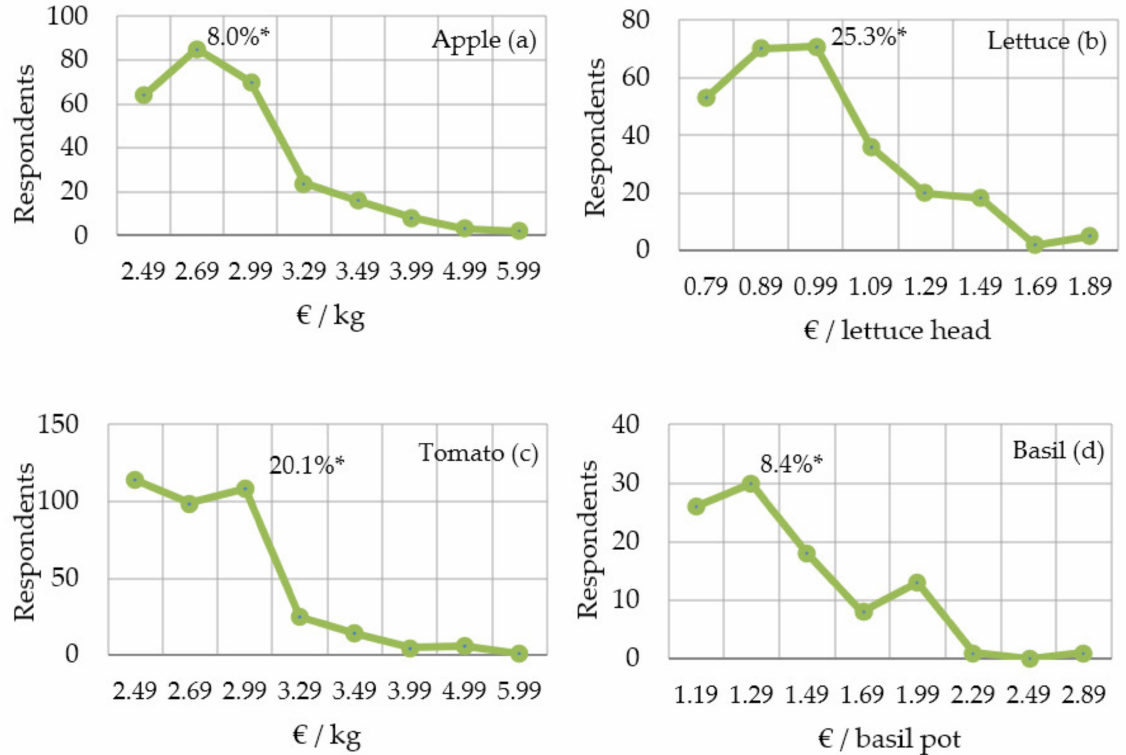
Figure 5. Development of willingness to pay for iodine-biofortified apples ( a ), lettuce ( b ), tomato ( c ), and potted basil ( d ) based on prices per kilogram. The lowest price always represents the current average market price. n = 1016. * Relative willingness to pay more with the highest number of potential